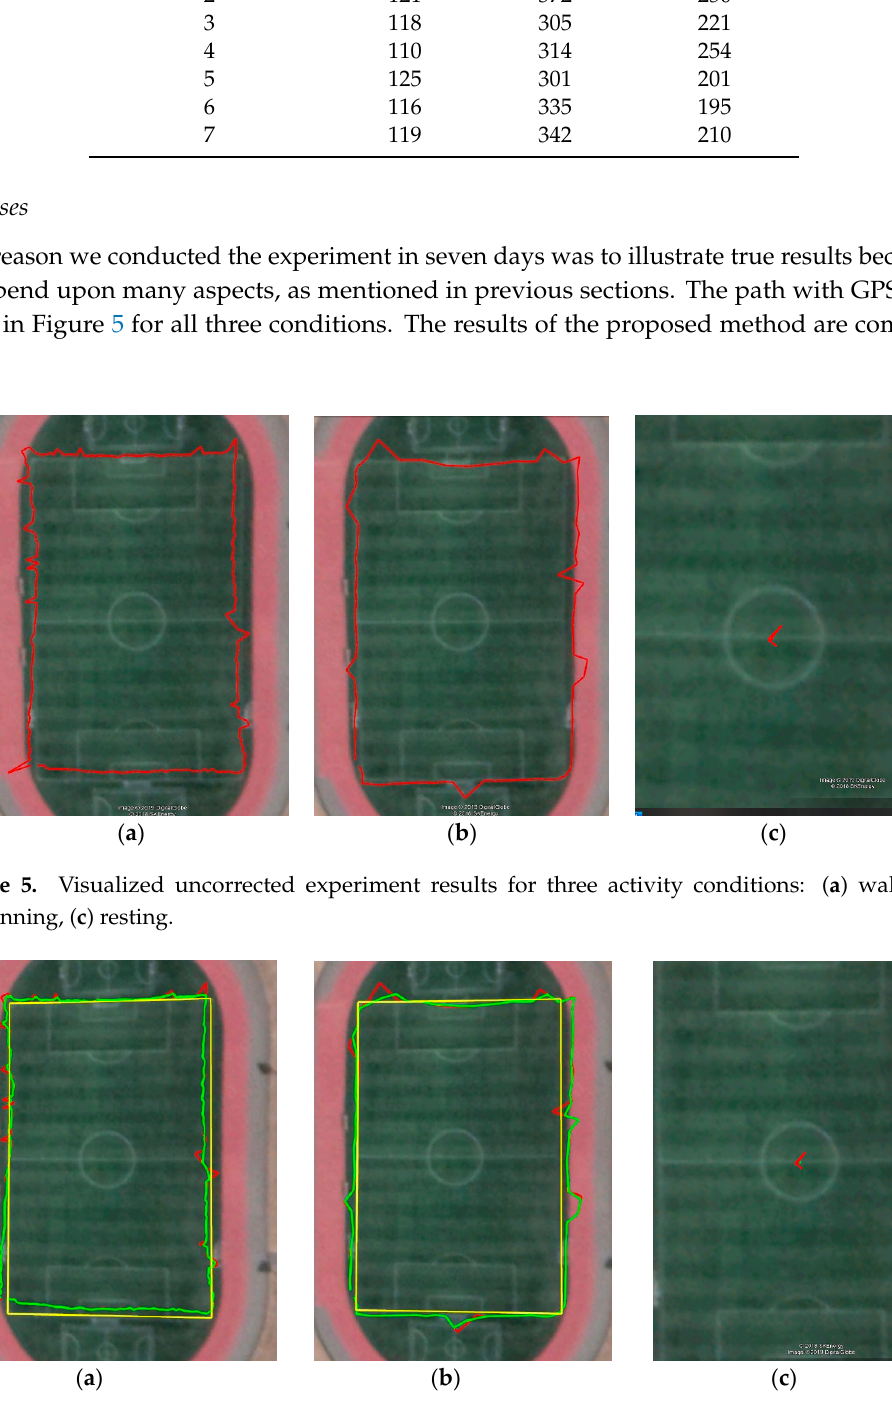
Figure 6. Visualized experiment results for three activity conditions: ( a ) walking, ( b ) running, ( c ) resting. Comparison of the positioning paths between true path (yellow line), unfiltered GPS receiver data (red line), and the proposed method (green line).